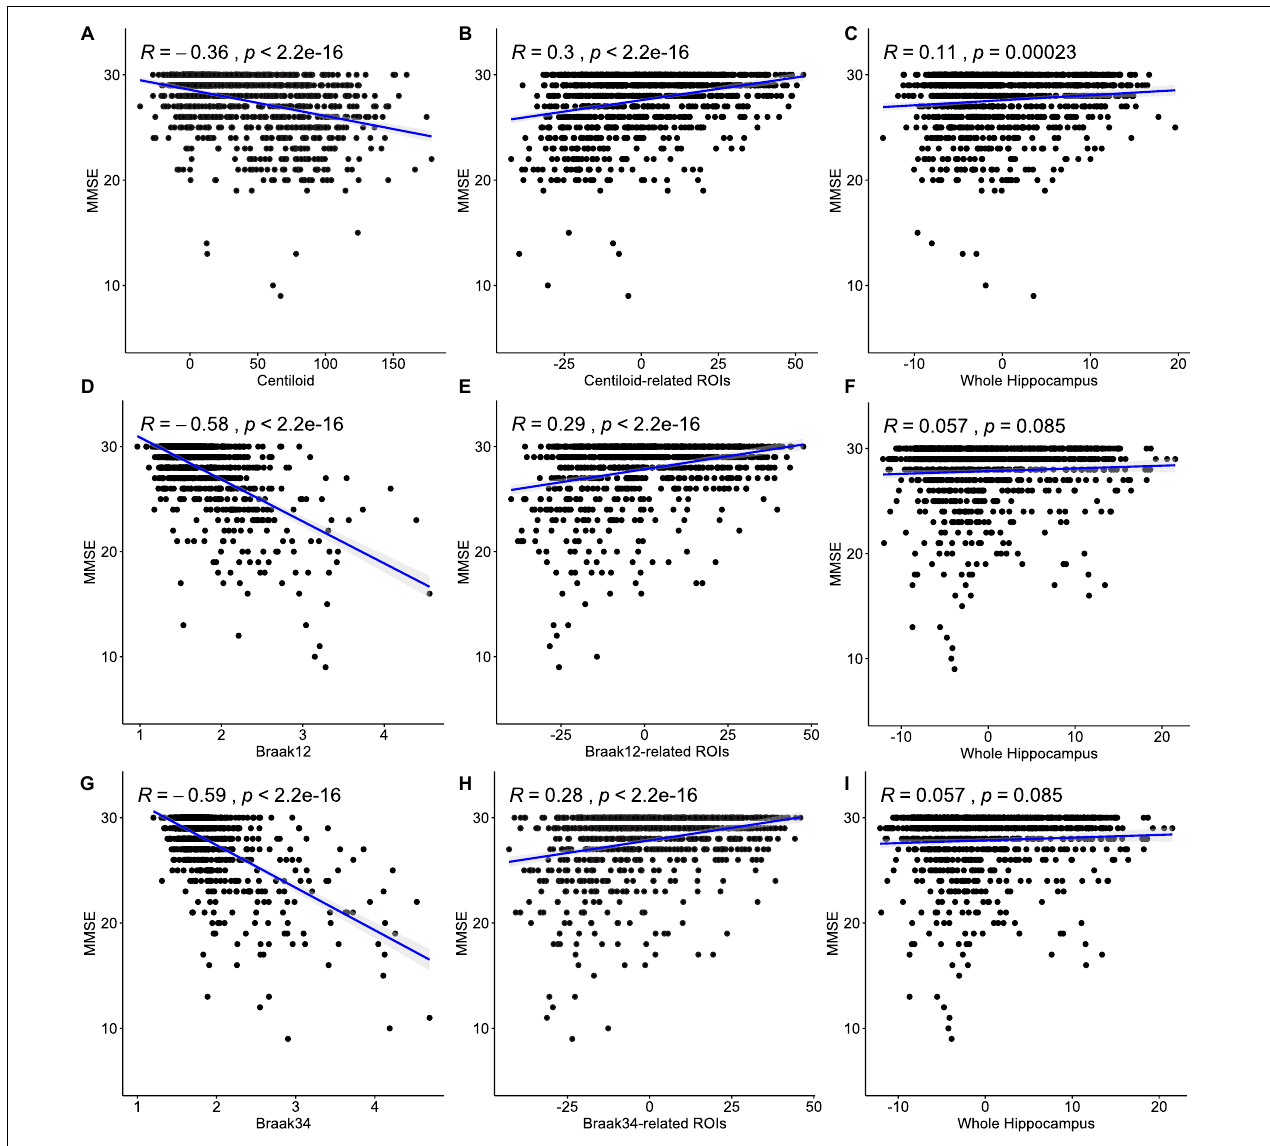
FIGURE 7 | Pearson correlation between the measures for A β and tau deposition and MMSE and between the morphometry features and MMSE. The first column (A,D,G) is the correlation between the measures for A β and tau deposition and MMSE. And the second column (B,E,H) is the correlation between the features on our selected ROIs and MMSE. The last column (C,F,I) is between the feature on the whole surface and MMSE. The correlation coefficients and p-values are shown in each subfigure.